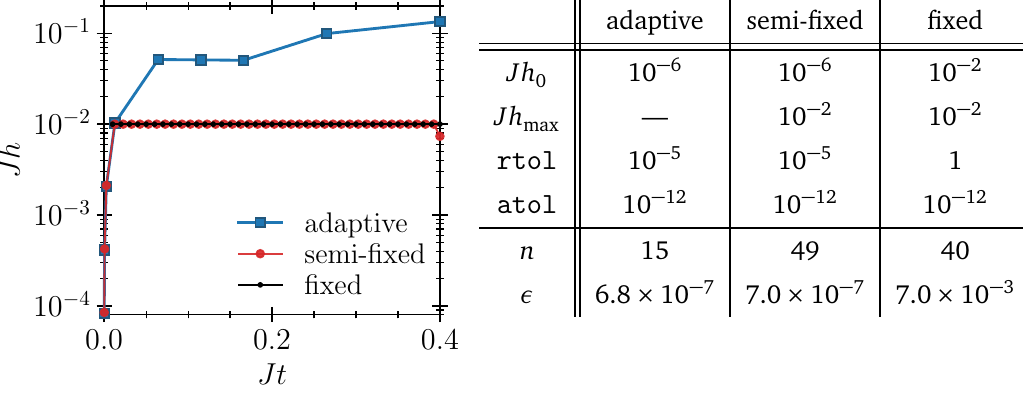
Figure 5 & Table 1: A comparison between adaptive and fixed stepping schemes for the two-site tight-binding model discussed in Section 4.1.1. The effective step size is denoted by h , the maximal allowed step size by h , and the tolerances rtol and max atol are discussed in Section 3.2.1. The adaptive scheme reduces the number of points n considerably, while also providing the smallest